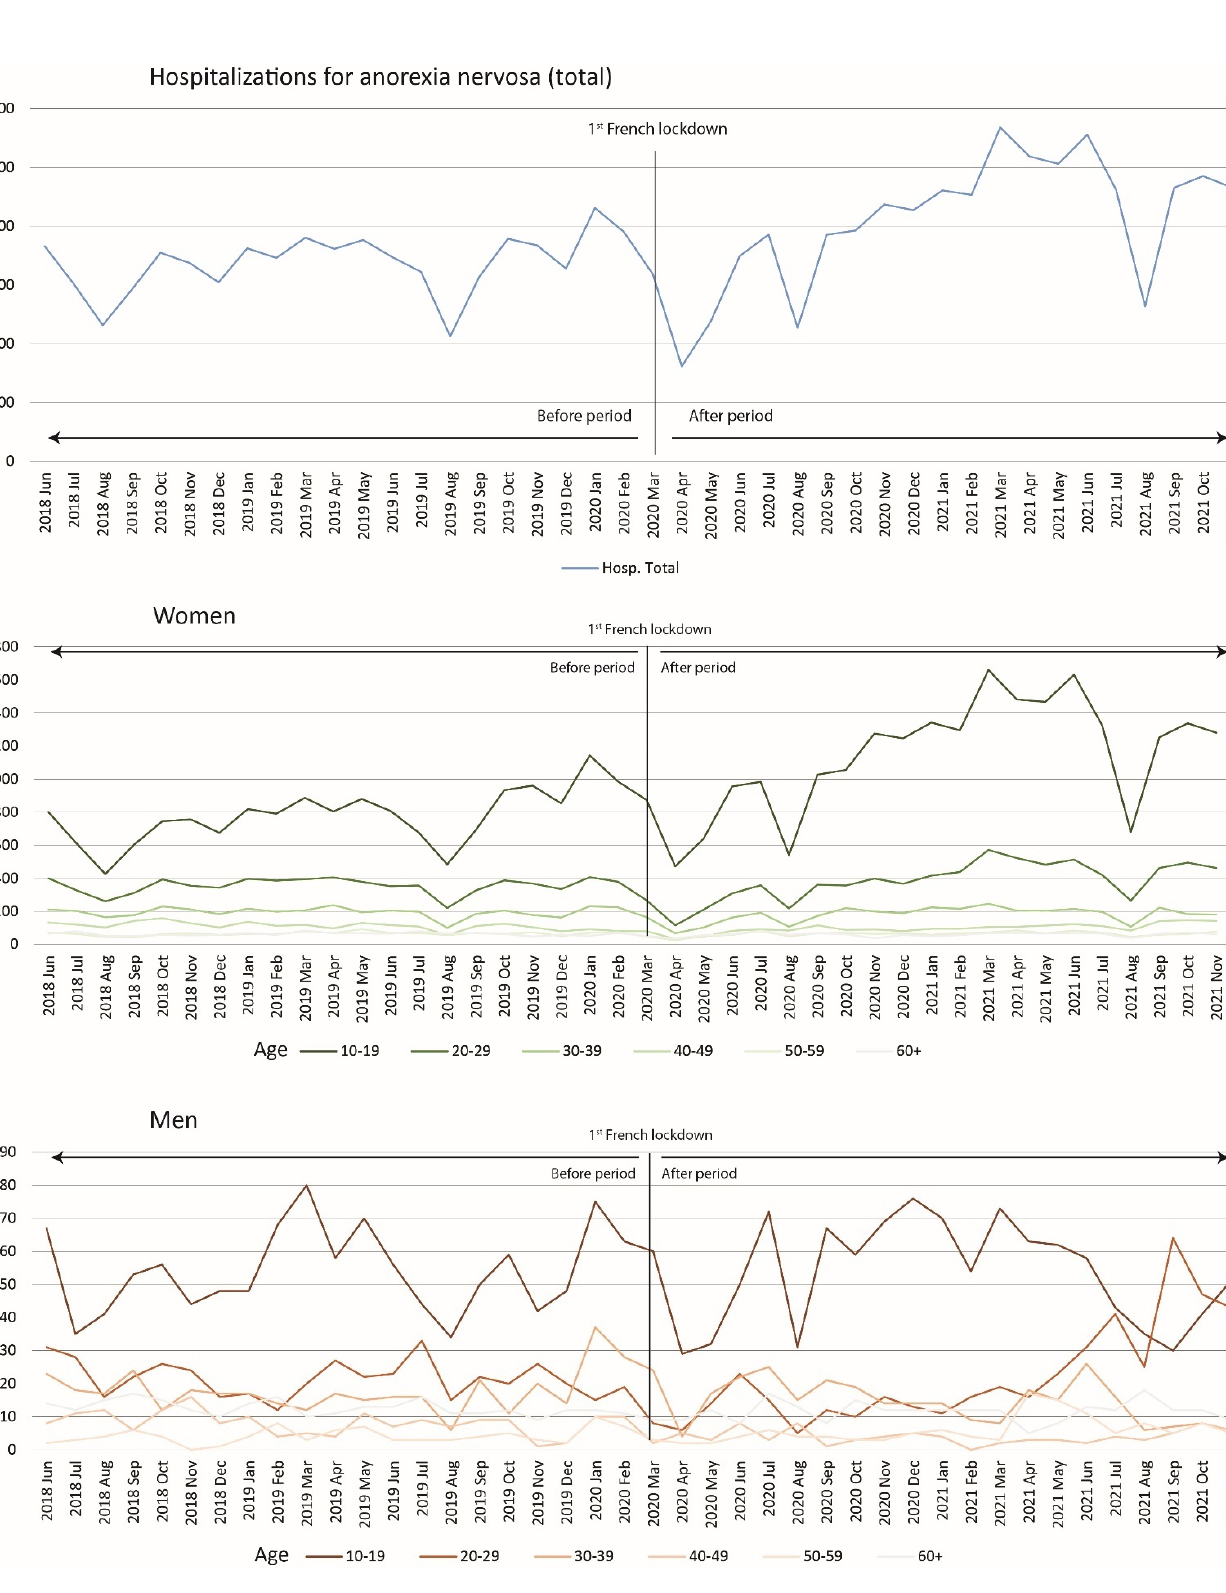
Figure 1. Number of monthly hospitalizations for patients with anorexia nervosa from June 2018 to November 2021: overall ( top ), in women by age group ( middle ) and in men by age group ( bottom ).